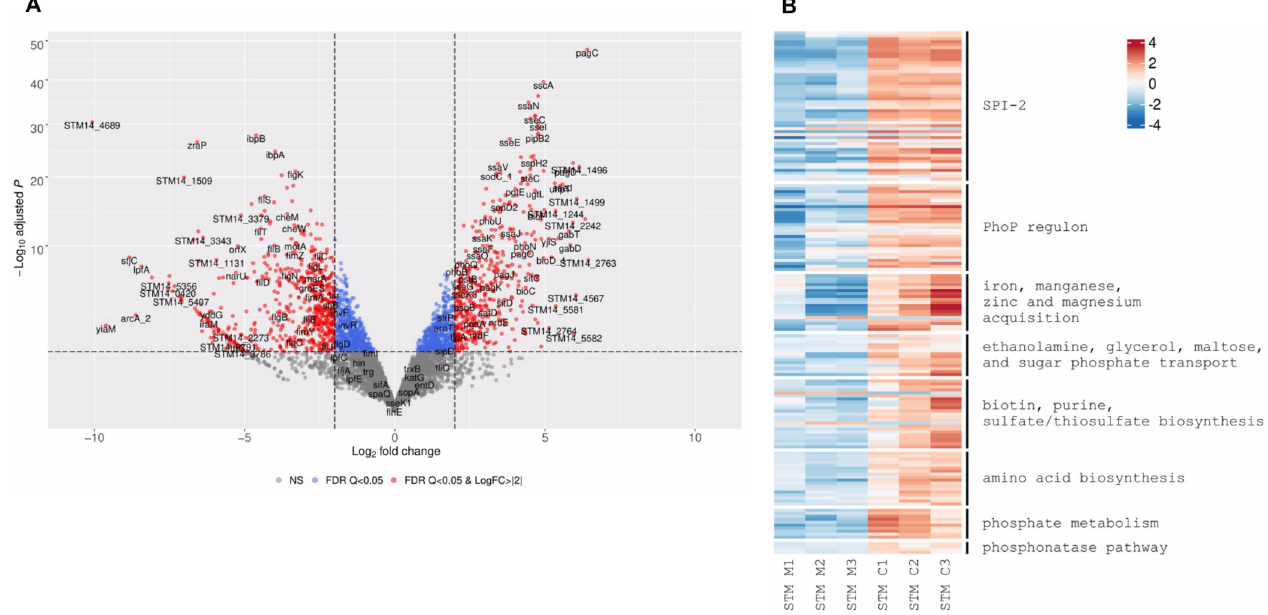
Fig 2. DEGs of intracellular S . Typhimurium compared to growth in LB medium. (A) a Volcano plot showing the fold change (log2 ratio) in the expression of STM genes grown intracellularly in HeLa cells (8 h p.i.) vs. the growth in LB medium (X-axis) plotted against the -log 10 adjusted p-value (Y-axis). Each dot on the plot represents the mean value (from three independent cultures) of one gene. Genes that were changed by more than twofold are colored in red. ( B ) Heatmap based on RNA-Seq results showing the relative transcription of STM genes of interest during intracellular infection (C1 to C3) vs. their extracellular expression in LB medium (M1 to